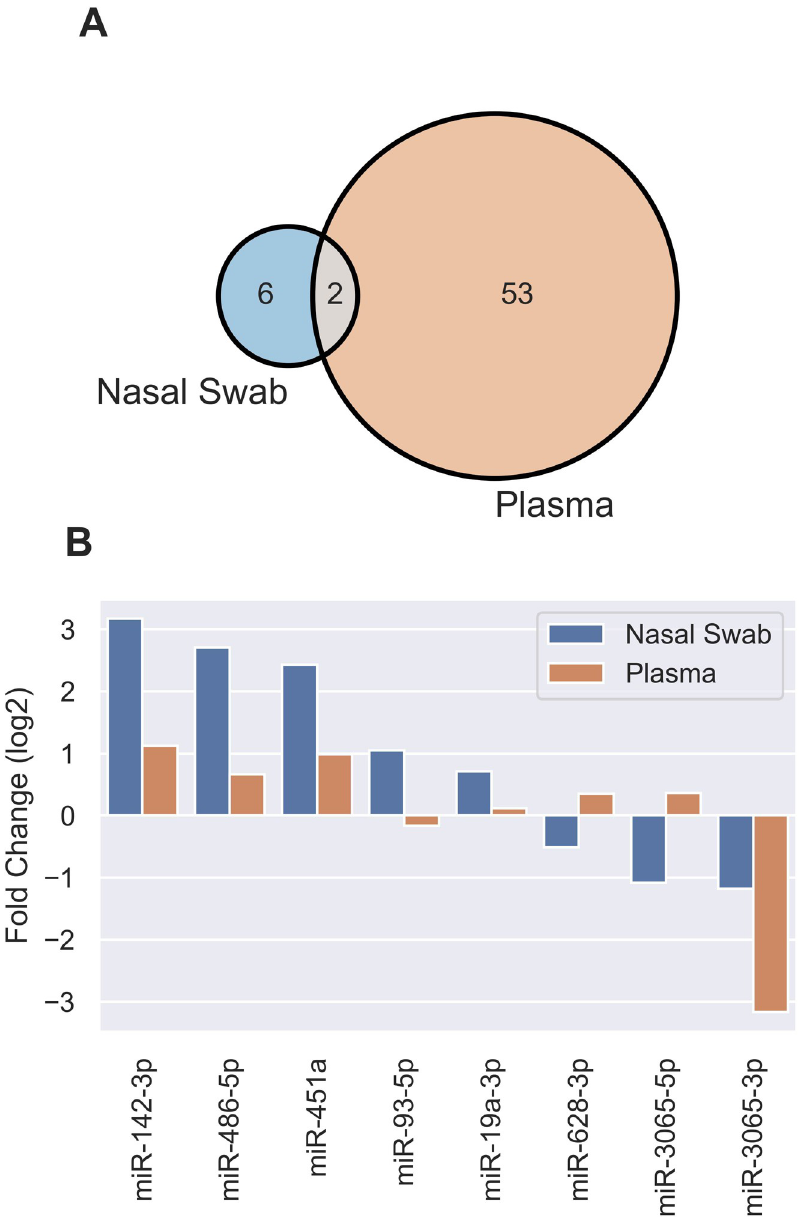
Fig 3. Comparisons of DE miRNAs induced by SARS-CoV-2 infection in nasal swabs and plasma. A, Venn diagram identifying DE miRNAs in plasma and nasal swabs miRNA datasets. B, Results from DE miRNA analysis from nasal swab and plasma datasets for the 8 miRNAs